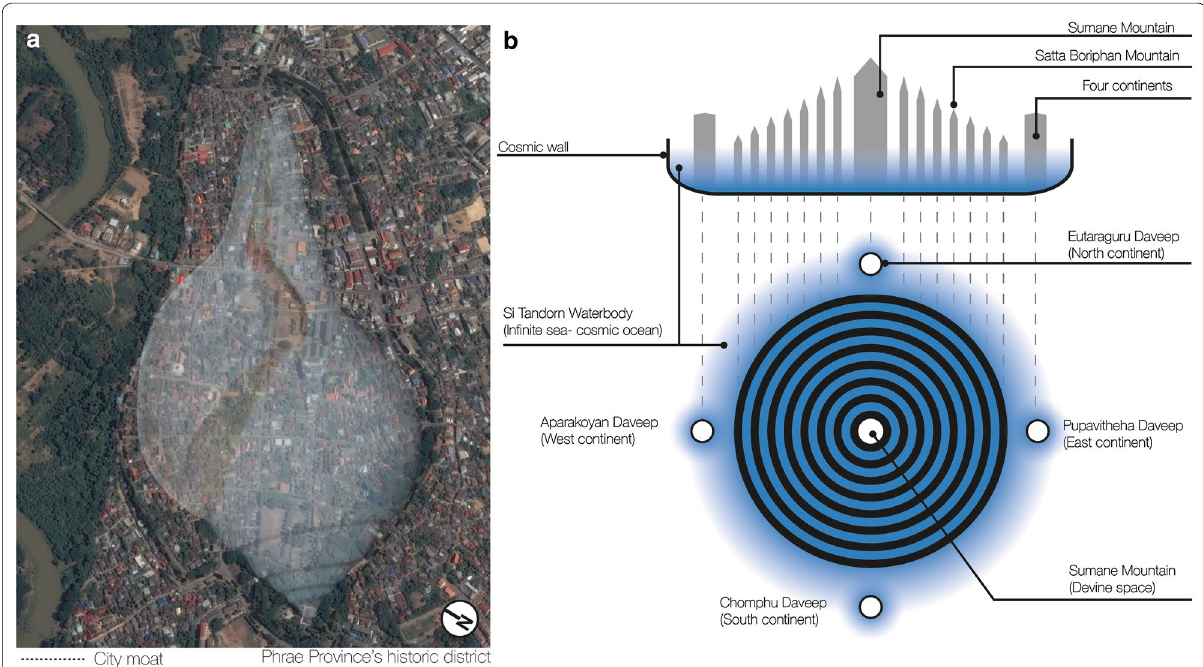
Fig. 2 a Sankh concept of Phrae’s historic city. b Traiphum